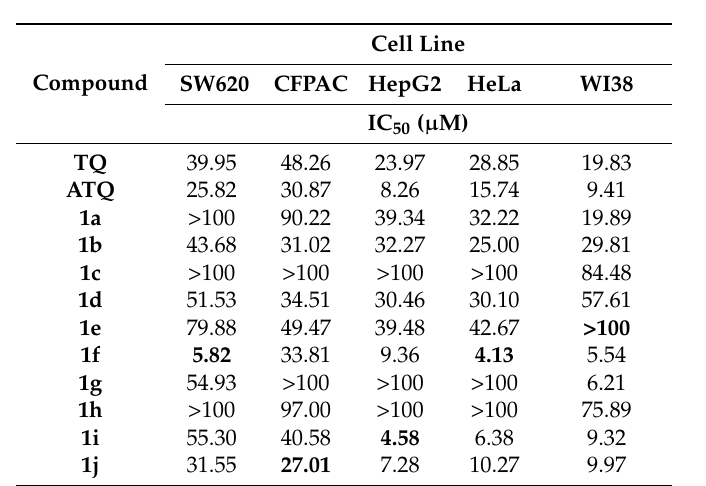
Table 3. IC 50 values (values at which 50% of cells are inhibited) ( µ M) of compounds TQ , ATQ , and 1a – 1j in tested cell lines. The most potent compound in each tumour cell line is bolded. The least toxic compound against WI38 is bolded. SW620, CFPAC, HepG2 and HeLa are carcinoma cell lines, WI38 is healthy control human fibroblast cell